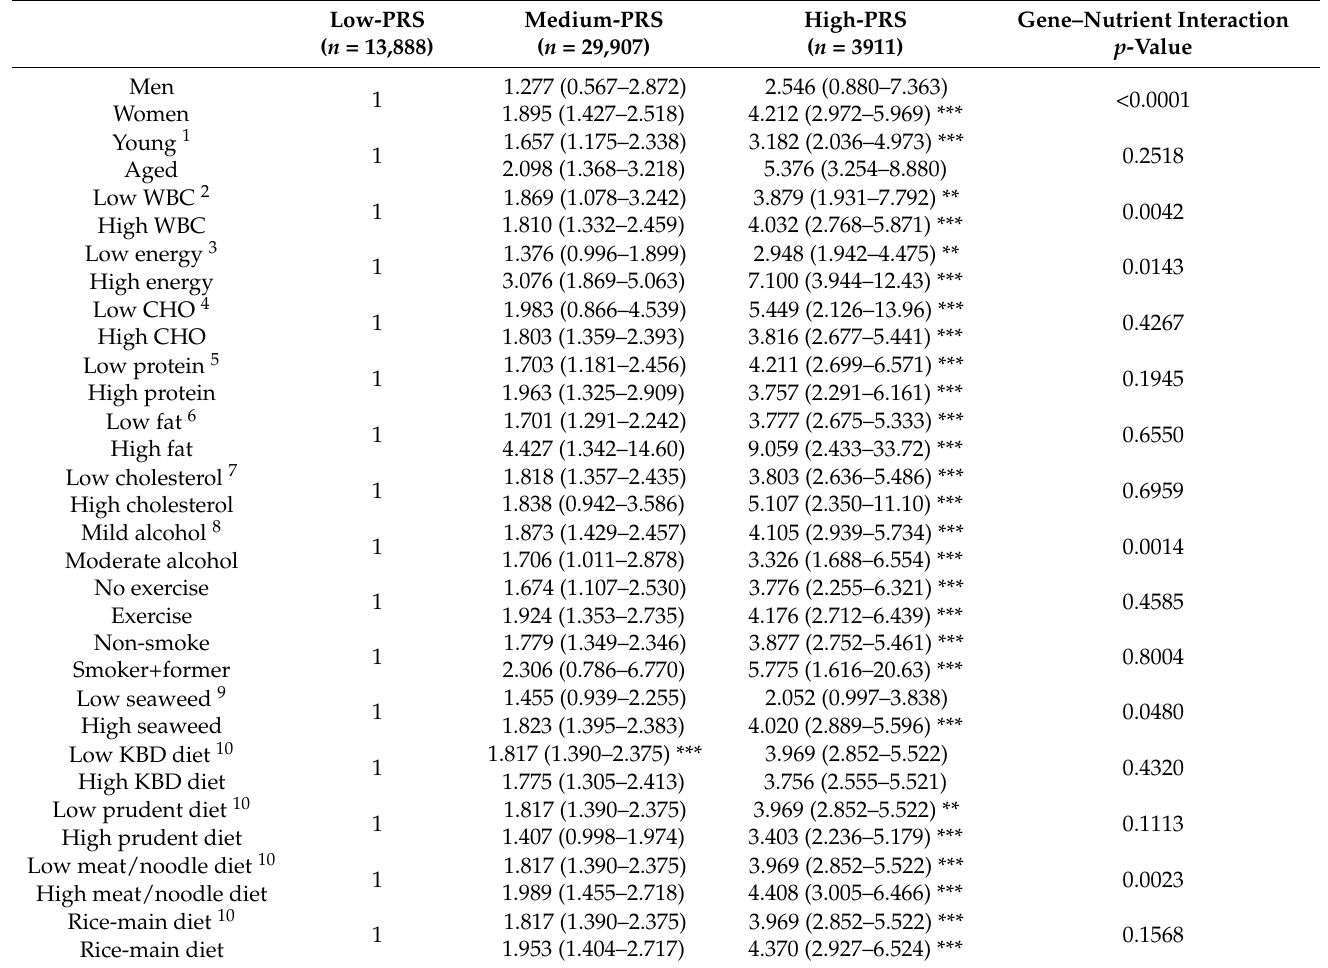
significant interaction was found between age and PRS, but the interaction between WBC count and PRS influenced thyroid cancer incidence ( p = 0.0042; Table 5). Participants with a high white blood cell count had a higher thyroid cancer rate than those with a low white blood cell count regardless of PRS (Figure 3B). Individuals in the high-PRS group with a low white blood cell count had a lower risk of thyroid cancer than those with a high white blood cell count (Table 5, Figure 3B), and individuals in the high-PRS group and a high white blood cell count had a higher risk of thyroid cancer by 4.03-fold than those in the low-PRS group and a high white blood cell count ( p < 0.001; Table 5). Table 5. Adjusted odds ratios (ORs) for thyroid cancer risk by polygenetic risk scores of the best model (PRS) for genetic variant-lifestyle interaction after covariate adjustments according to lifestyle